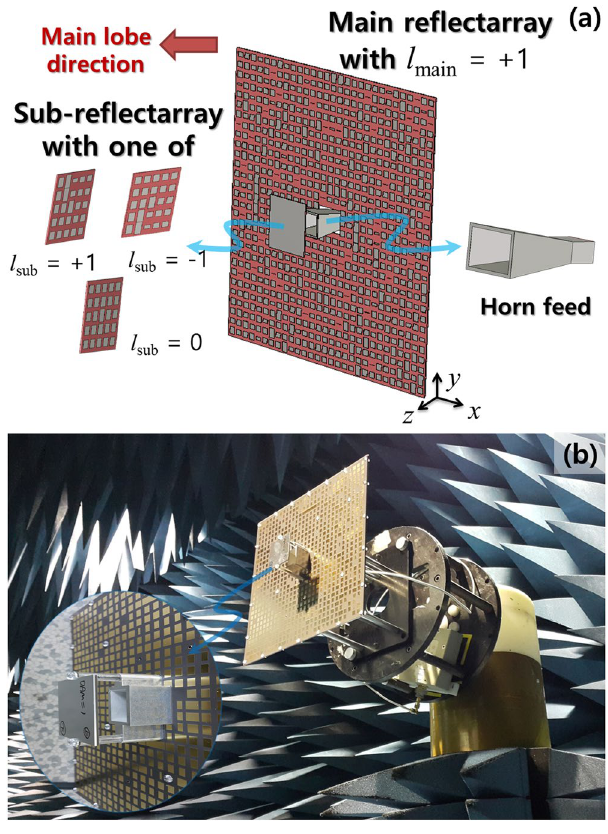
Figure 1. (a) Conceptual setup of a Cassegrain dual-reflectarray antenna with main and sub-reflectarrays to verify the mode combining and canceling in the near-field by manually replacing the sub-reflectarray substrates ( = ± l 0, 1 ). The main reflectarray substrate generated the fixed OAM mode number l main = + 1 for all sub simulations and measurements. (b) Image of far-field measurement setup with attached fabricated main and sub-reflectarrays. The reflectarray antennas were implemented using microstrip patches and fed by ordinary horn